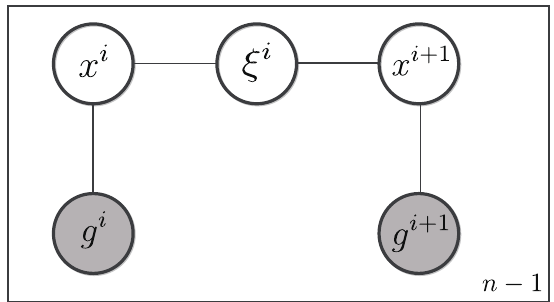
Figure 5. A conditional random field (CRF) model with n